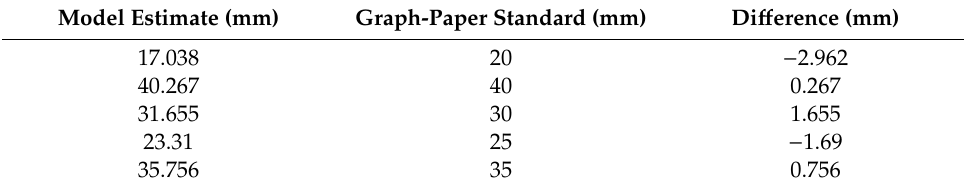
Table 3. Repeated application of the corrected isosceles-triangle model for distance measurements.